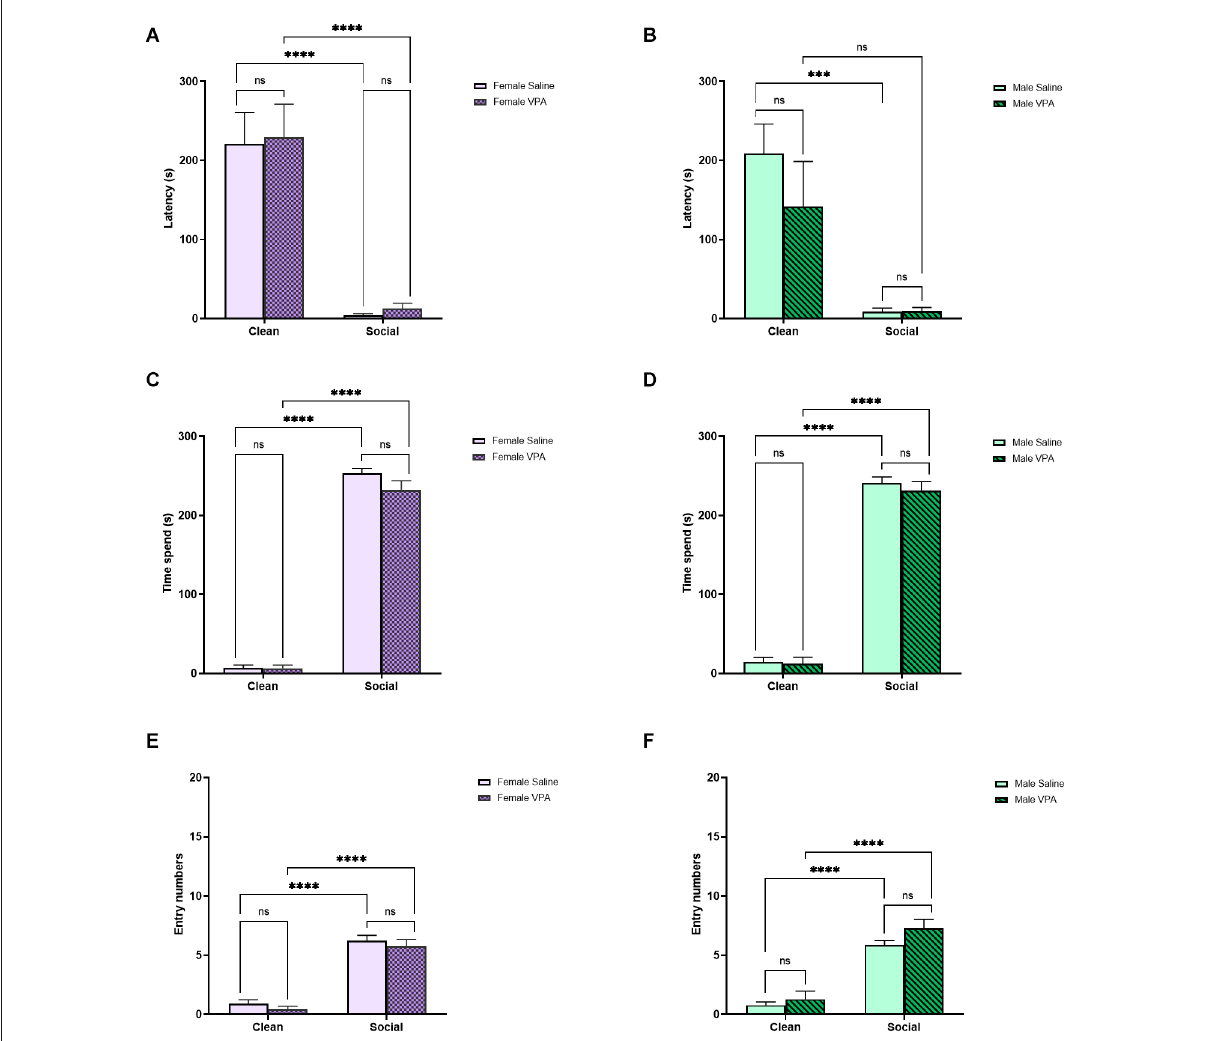
FIGURE4 (A,B) P13 Sex differences: latency to enter zones. Data expressed as mean ± standard error of the mean. We observed a significant main effect of bedding type in females (A) , p < 0.0001, and males (B) , p < 0.0001. (C,D) P13 Sex differences: time spent in zones. Data expressed as mean ± standard error of the mean. We observed a significant main effect of bedding in both females (C) , p < 0.0001, and males (D) , p < 0.0001. (E,F) P13 Sex differences: number of zone entries. Data expressed as mean ± standard error of the mean. We observed a significant main effect of bedding in both females (C) , p < 0.0001, and males (D) , p < 0.0001. ∗∗∗ p = 0.0001–0.001; ∗∗∗∗ p < 0.0001; ns = p >